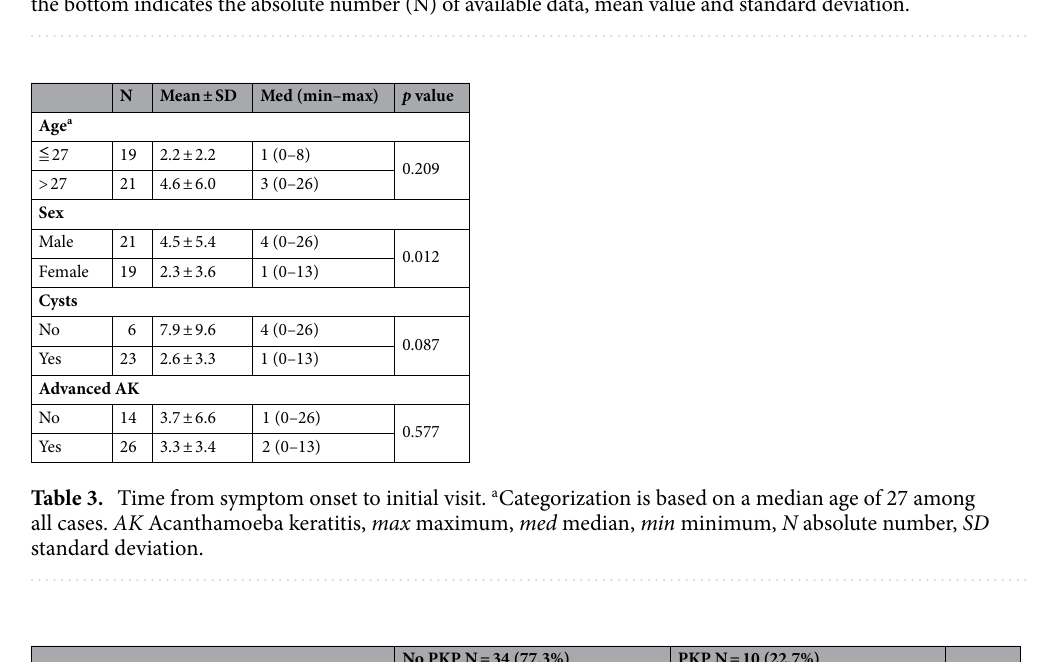
Figure 2. Boxplots of best spectacle-corrected visual acuity (BSCVA) courses within the first 12 months measured at initial presentation, after 1 month, after 3 months, after 6 months and after 12 months. The table in the bottom indicates the absolute number (N) of available data, mean value and standard deviation.